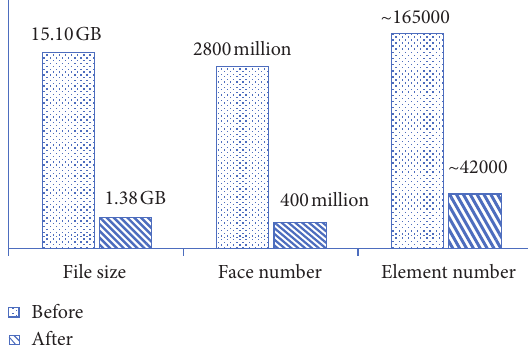
Figure 3: Model volume comparison before and after geometry